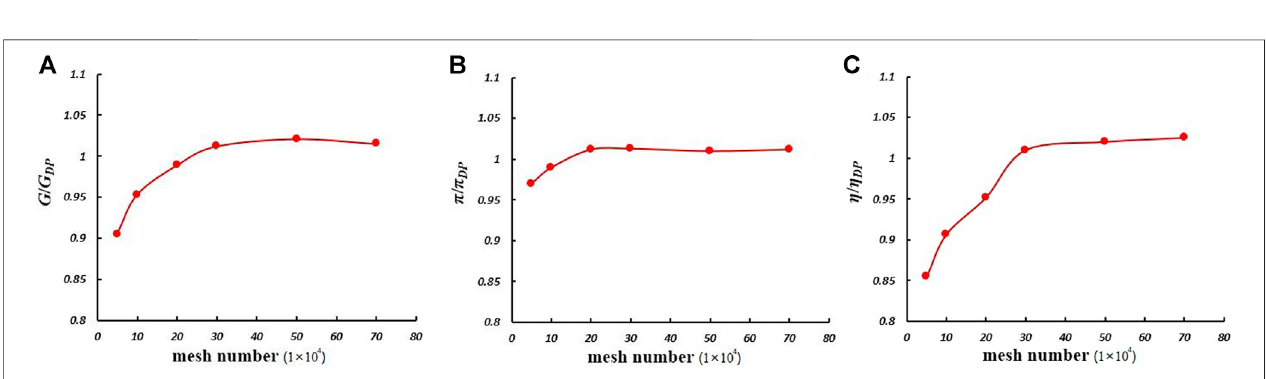
FIGURE 4 | Grid sensitivity analysis for the computational results of total performance parameters. Corrected mass fl ow (A) , Total pressure ratio (B) , Isentropic ef fi ciency (C) .